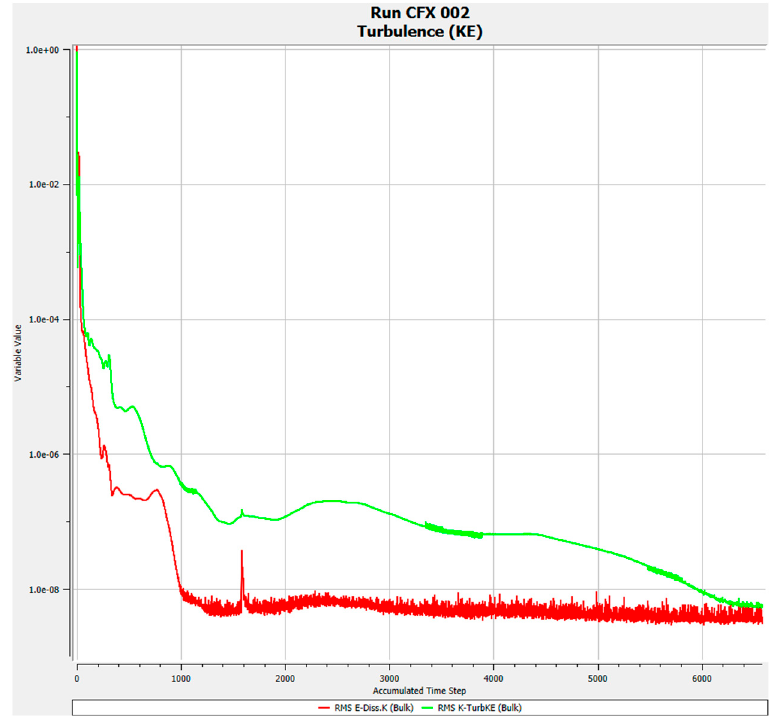
Figure 9. RMS residuals for k and ε values (initial mesh).